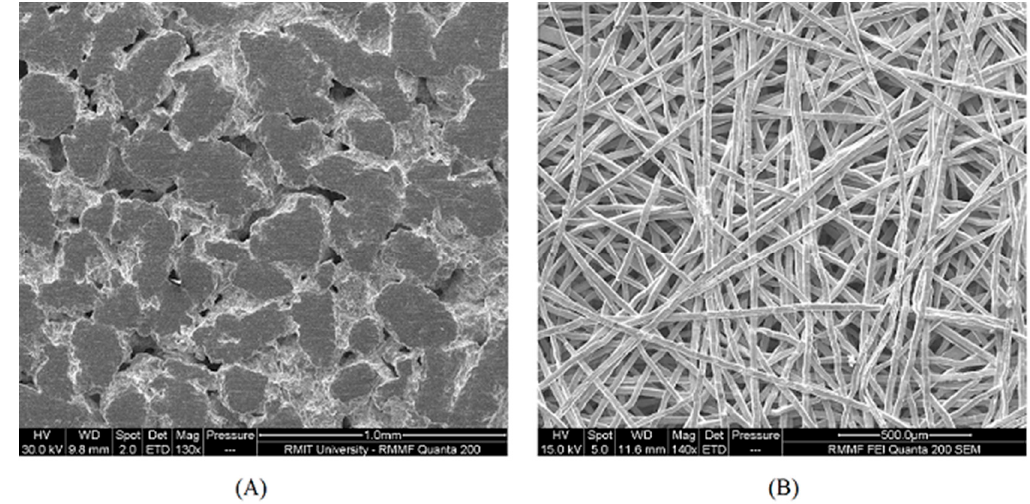
Figure 1. SEM images of sintered titanium powder ( A ) and sintered titanium fibre ( B ) commonly used as a gas diffusion layer (GDL) in unitised regenerative fuel cells (URFCs) and electrolysers.